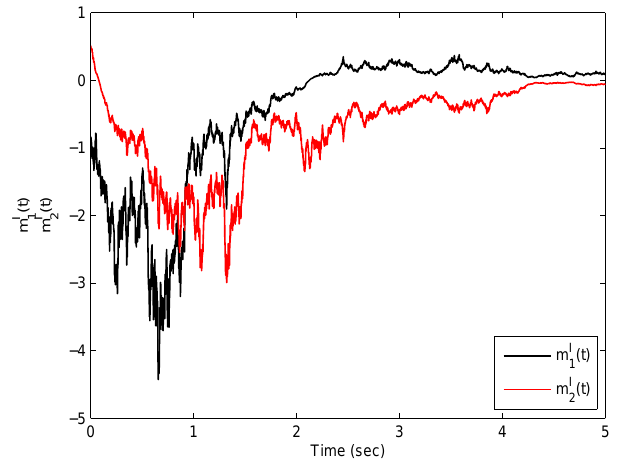
( t ) , m I ( t ) pertaining to the SMQVNN 2 1